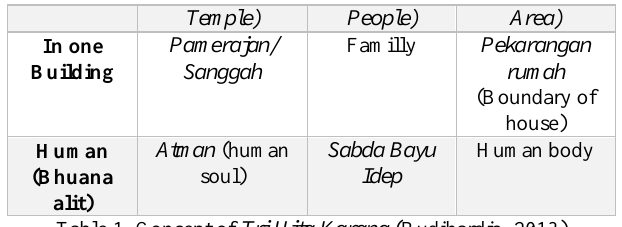
Table 1. Concept of Tri Hita Karana (Budihardjo, 2013) The basis of the concept comes from the ejection of Asta